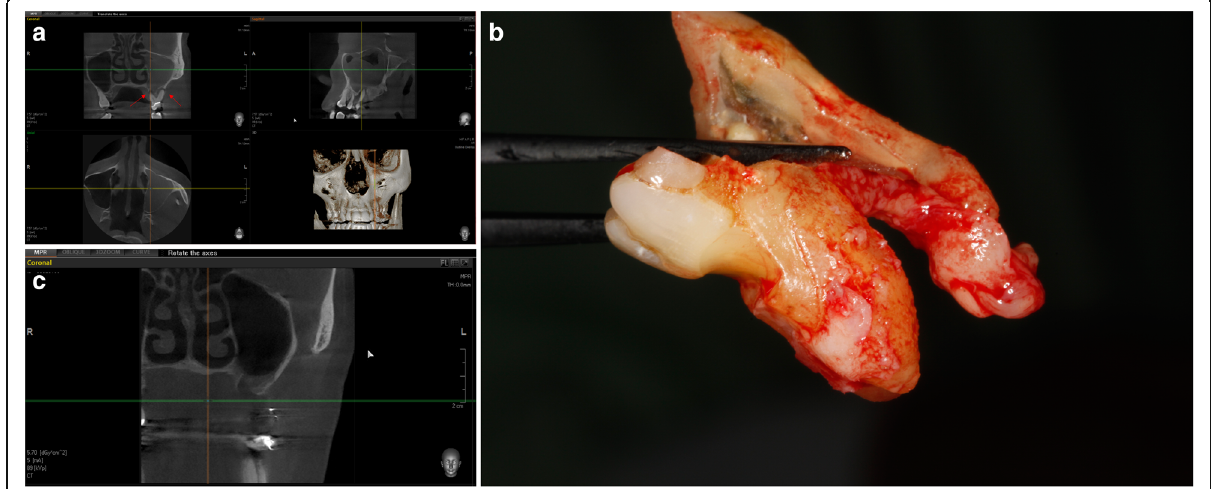
Fig. 5 a CBCT of a molar with a periapical disease causing a maxillary sinusitis. b Extracted molar. c CBCT after a healing period of 3